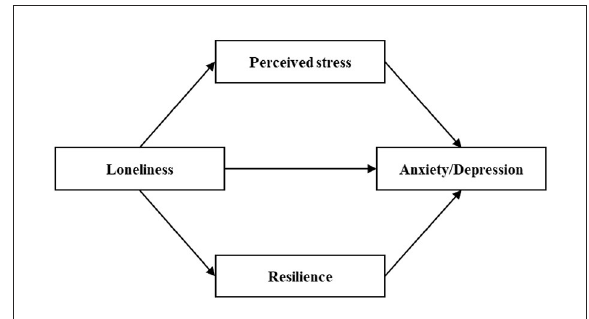
FIGURE1 Hypothesized relationships between loneliness, perceived stress, resilience, anxiety and